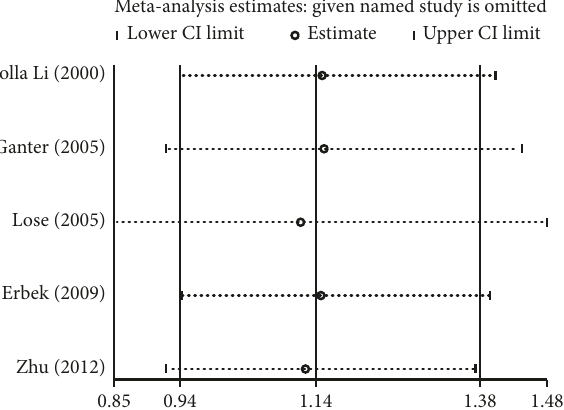
Figure 5: Sensitivity analysis for the MMP-9 − 1562 C > T, rs3918242 polymorphism with asthma susceptibility under the allele model comparison.